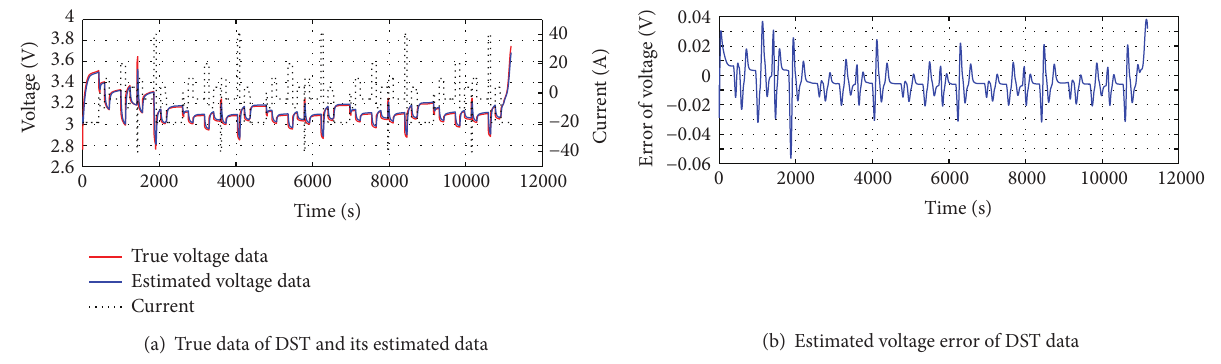
Figure 5: The results of model validation with DST